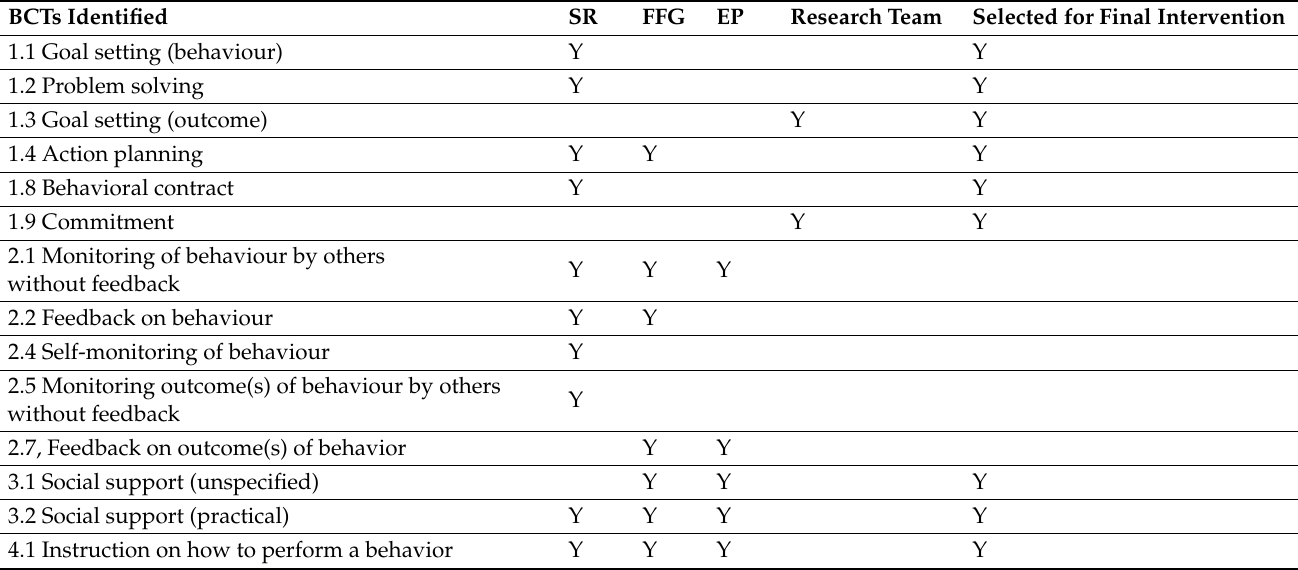
Table A3. Summary of BCTs identified at different